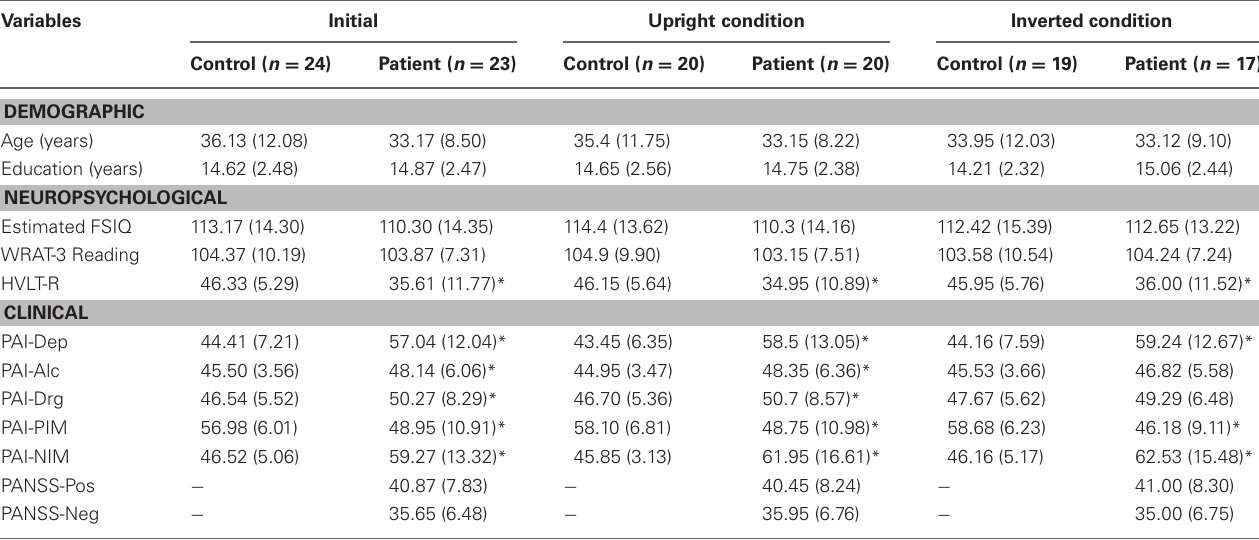
Table 1 | Means (SD) for demographic, neuropsychological, and clinical characteristics of the sample.